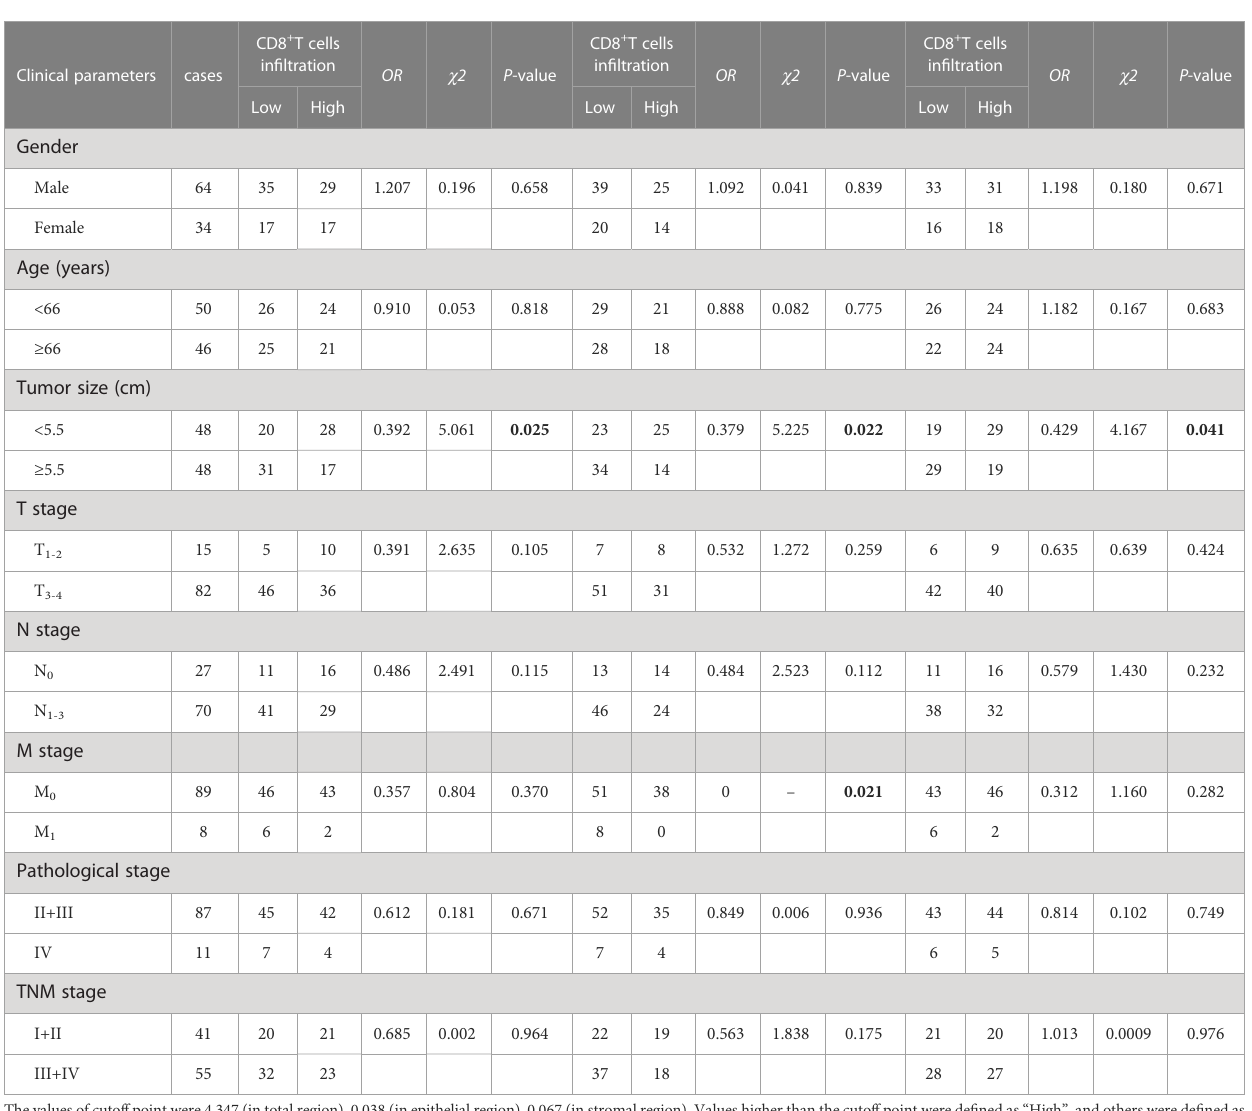
TABLE 1 The association between the percentages of CD8 + T cells, CD8 + T cells in the epithelial cell region, CD8 + T cells in the stromal cell region in tumor and clinical features of GC patients.